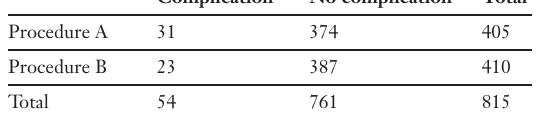
Table 1 Numbers of patients exhibiting or not exhibiting a post-op- erative complication after two surgical procedures.